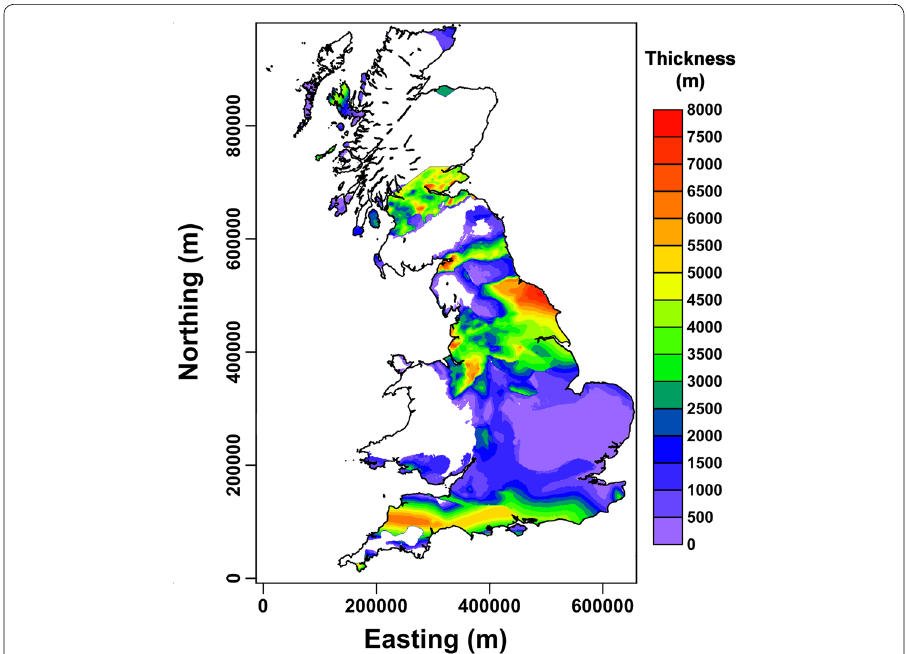
Fig. 2 Sediment thickness model to base Devonian, which also defines the depth to basement, derived from the BGS Lithoframe 1:1M model. Areas in white are exposed